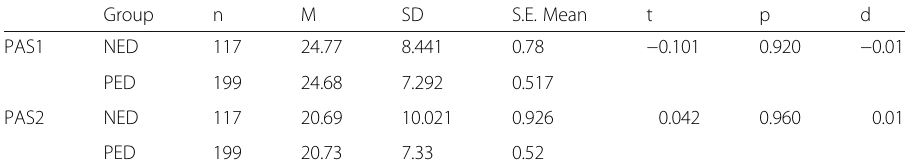
Table 2 Mean score and standard deviation on PAS scores for two groups Group n M SD